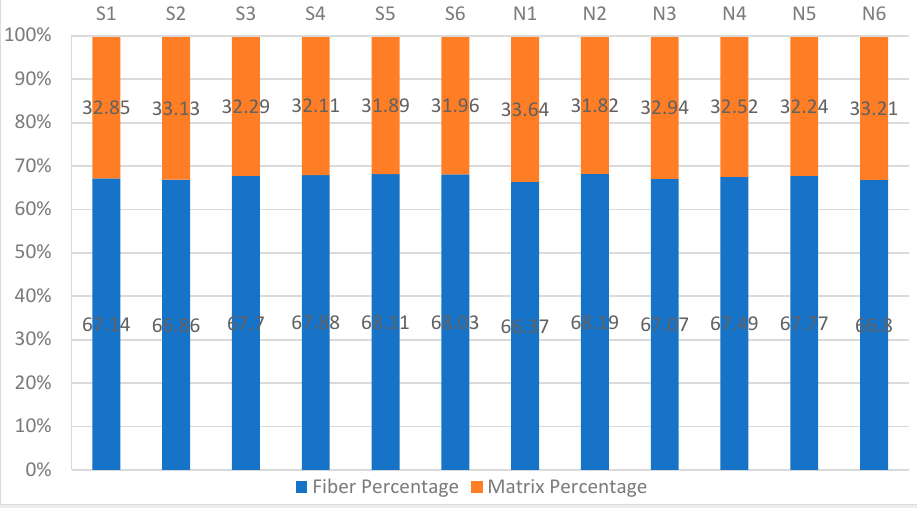
Table 2. Statistics of sample tested by acid digestion.